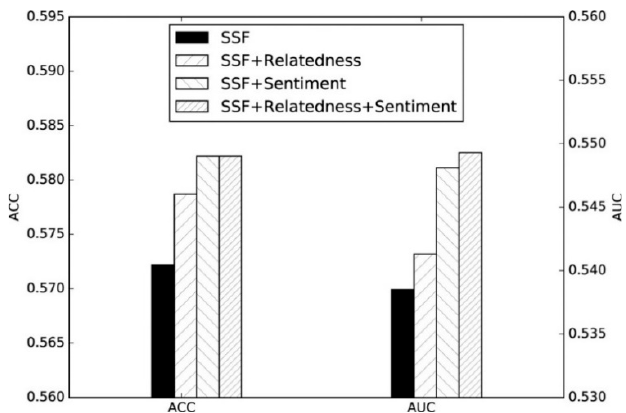
Figure 4. Prediction results trained on different combinations of features with SVM [25].